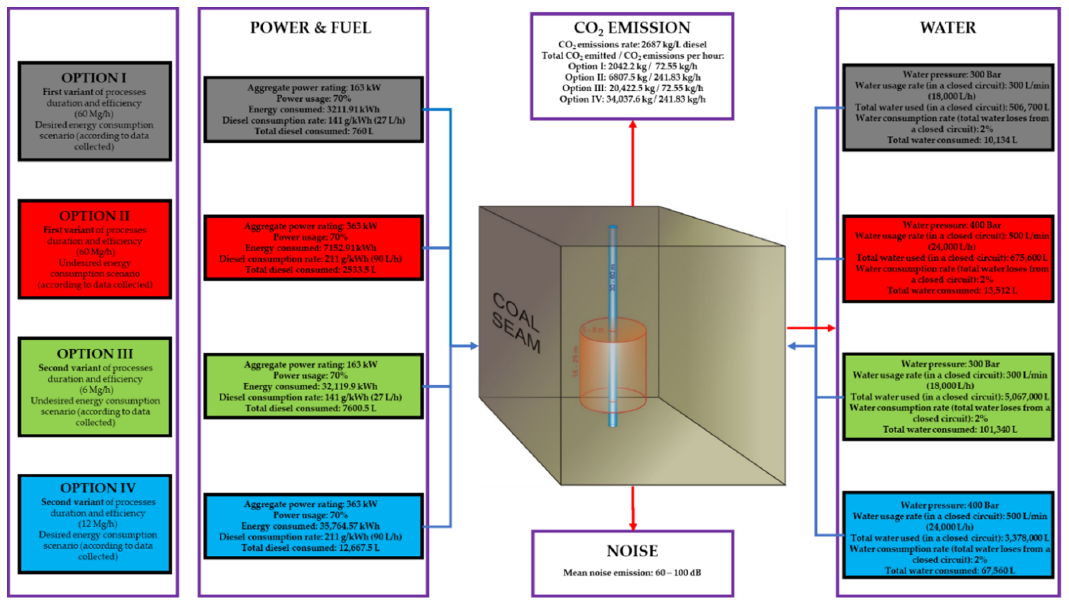
Figure 5. The results of the data collection for the lignite hydro ‐ cutting unit process.